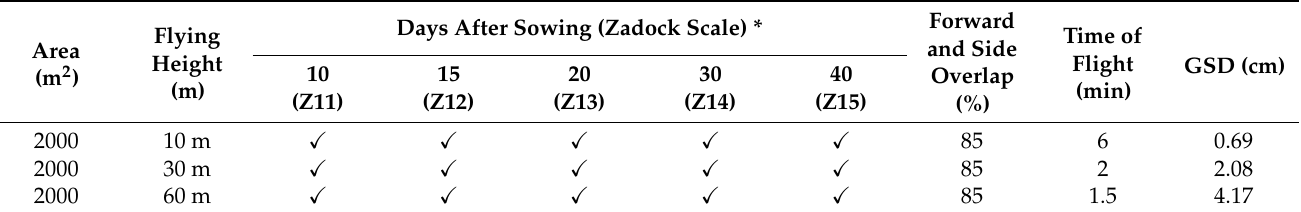
Table 1. Details of UAV flight